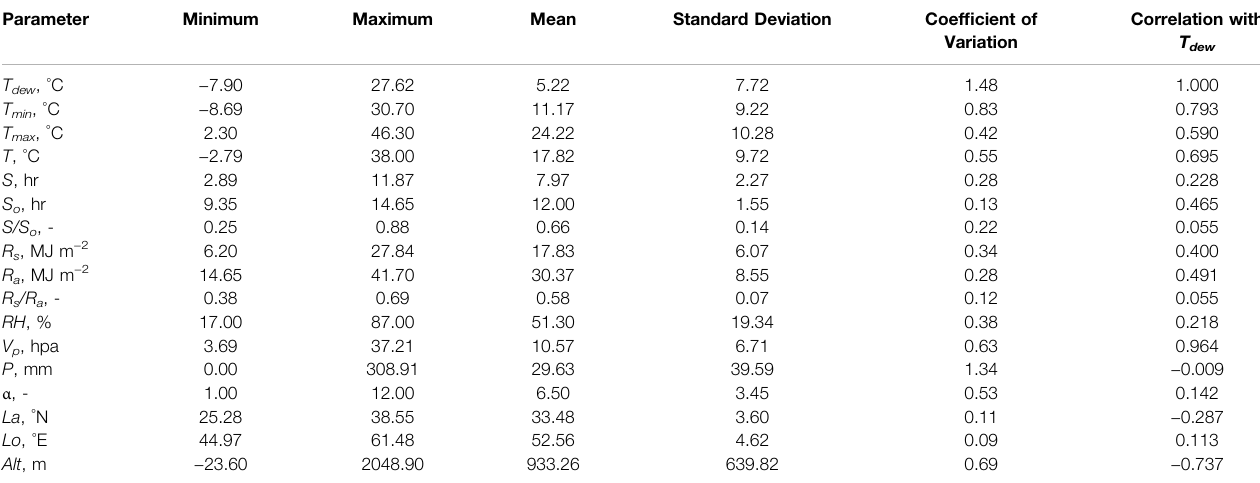
TABLE 2 | Statistical characteristics of long-term mean monthly meteorological data. Parameter